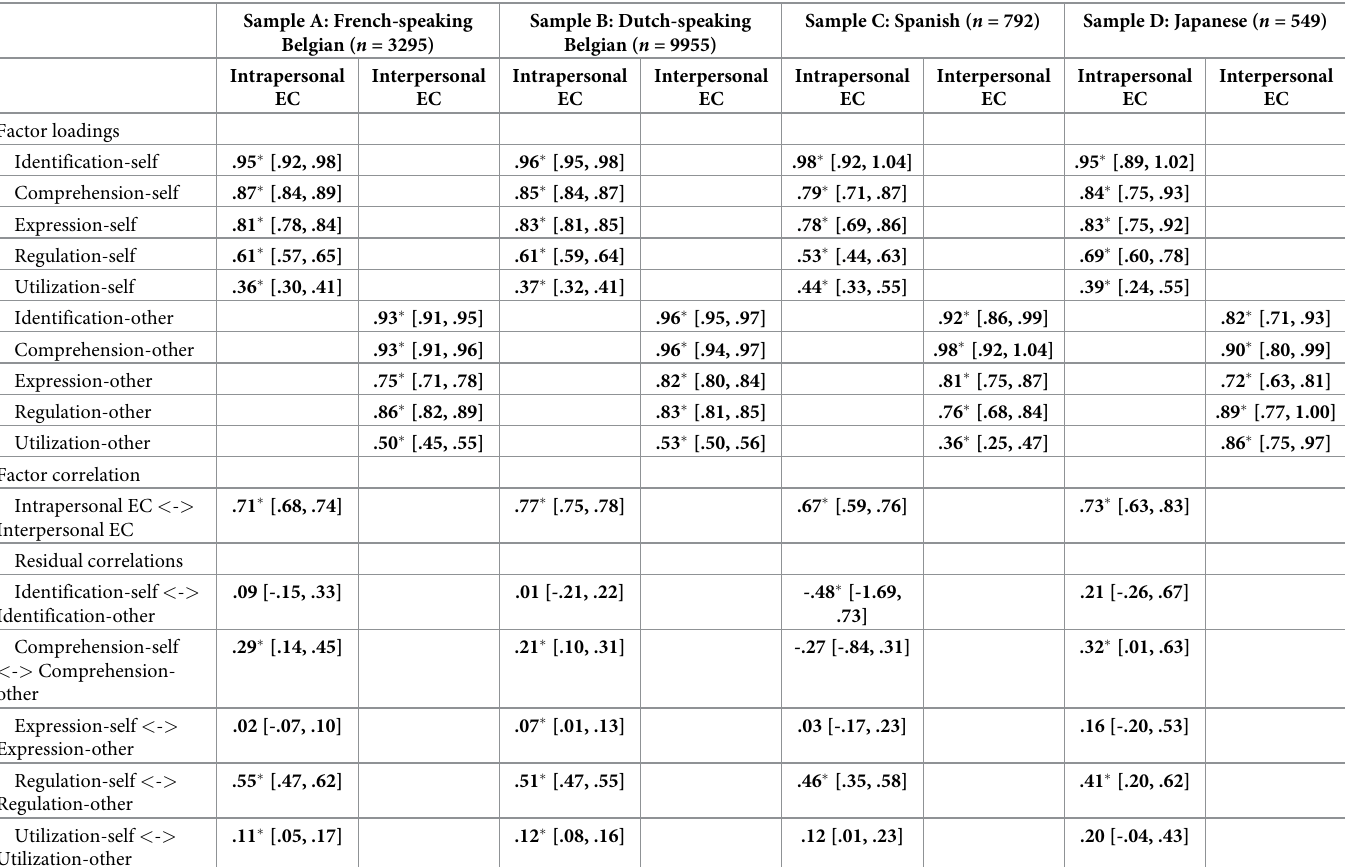
Table 2. Results of the CFA with a robust maximum likelihood estimation of the modified target-based structure model. Sample A: French-speaking Belgian ( n =